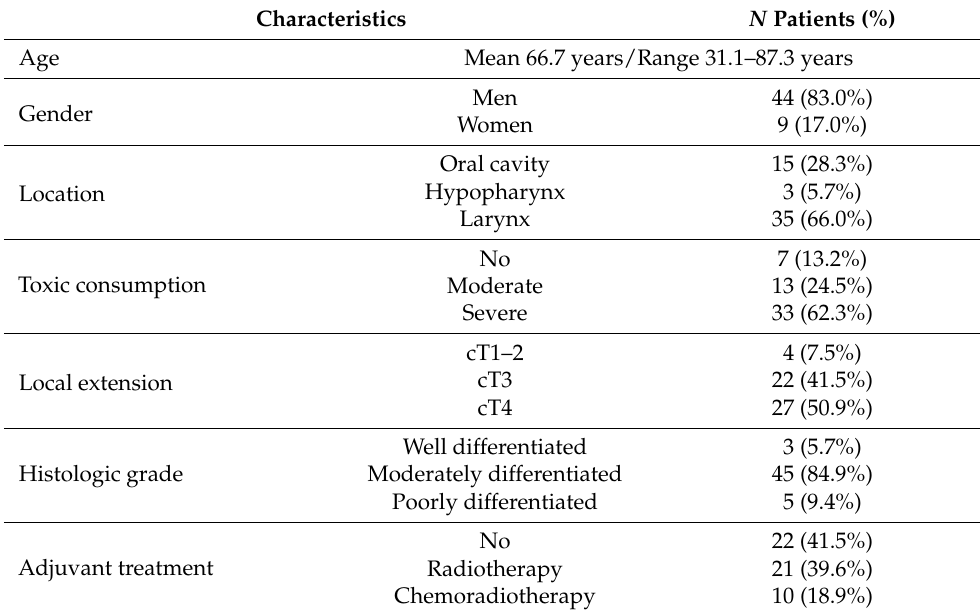
Table 1. Characteristics of the patients included in the